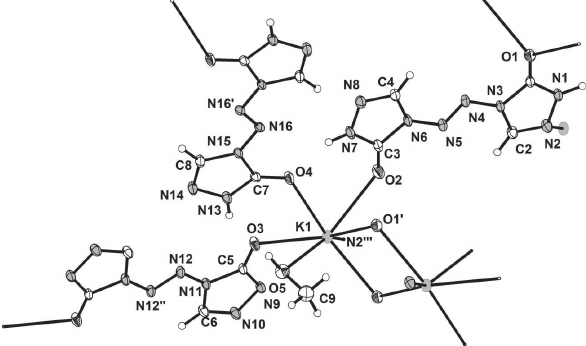
Table 1: Data collection and handling.